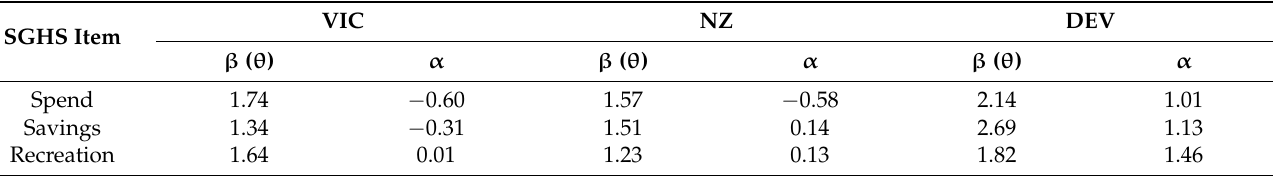
Table A1. Rasch model (IRT) discrimination ( β ) and difficulty ( α ) values SGHS items in each